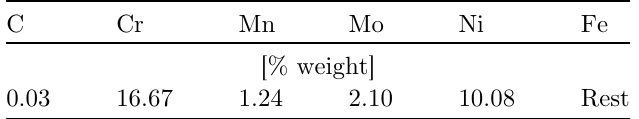
Table 2. Chemical composition of